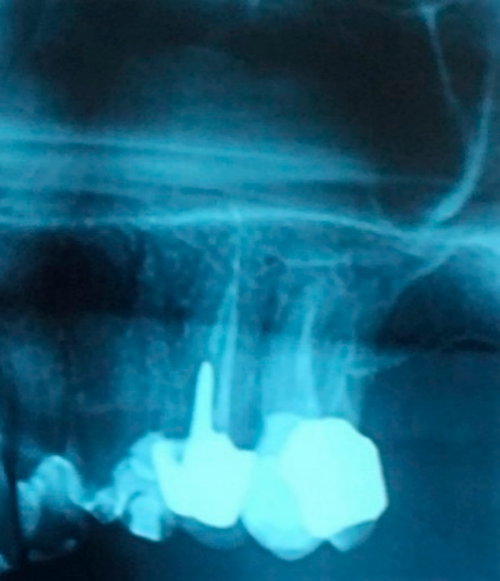
Figure 1. Detail of the patient’s orthopantomography (OPT) showing the first left upper molar candidate for extraction.